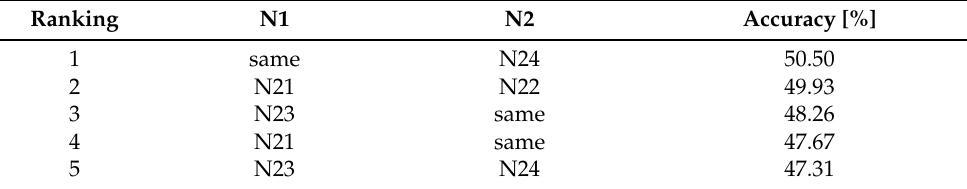
Table 12. Top five recognition accuracies after changing branch